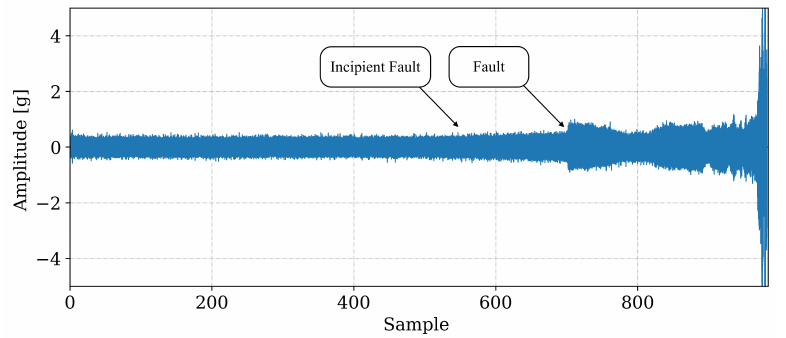
Figure 4. Complete waveform for the bearing under test, from start of monitoring to complete failure. The arrows indicate the instant where, through the analysis of the signals, the beginning of the fault (Incipient Fault) was noticed and the moment where the incipient fault progressed to a fault